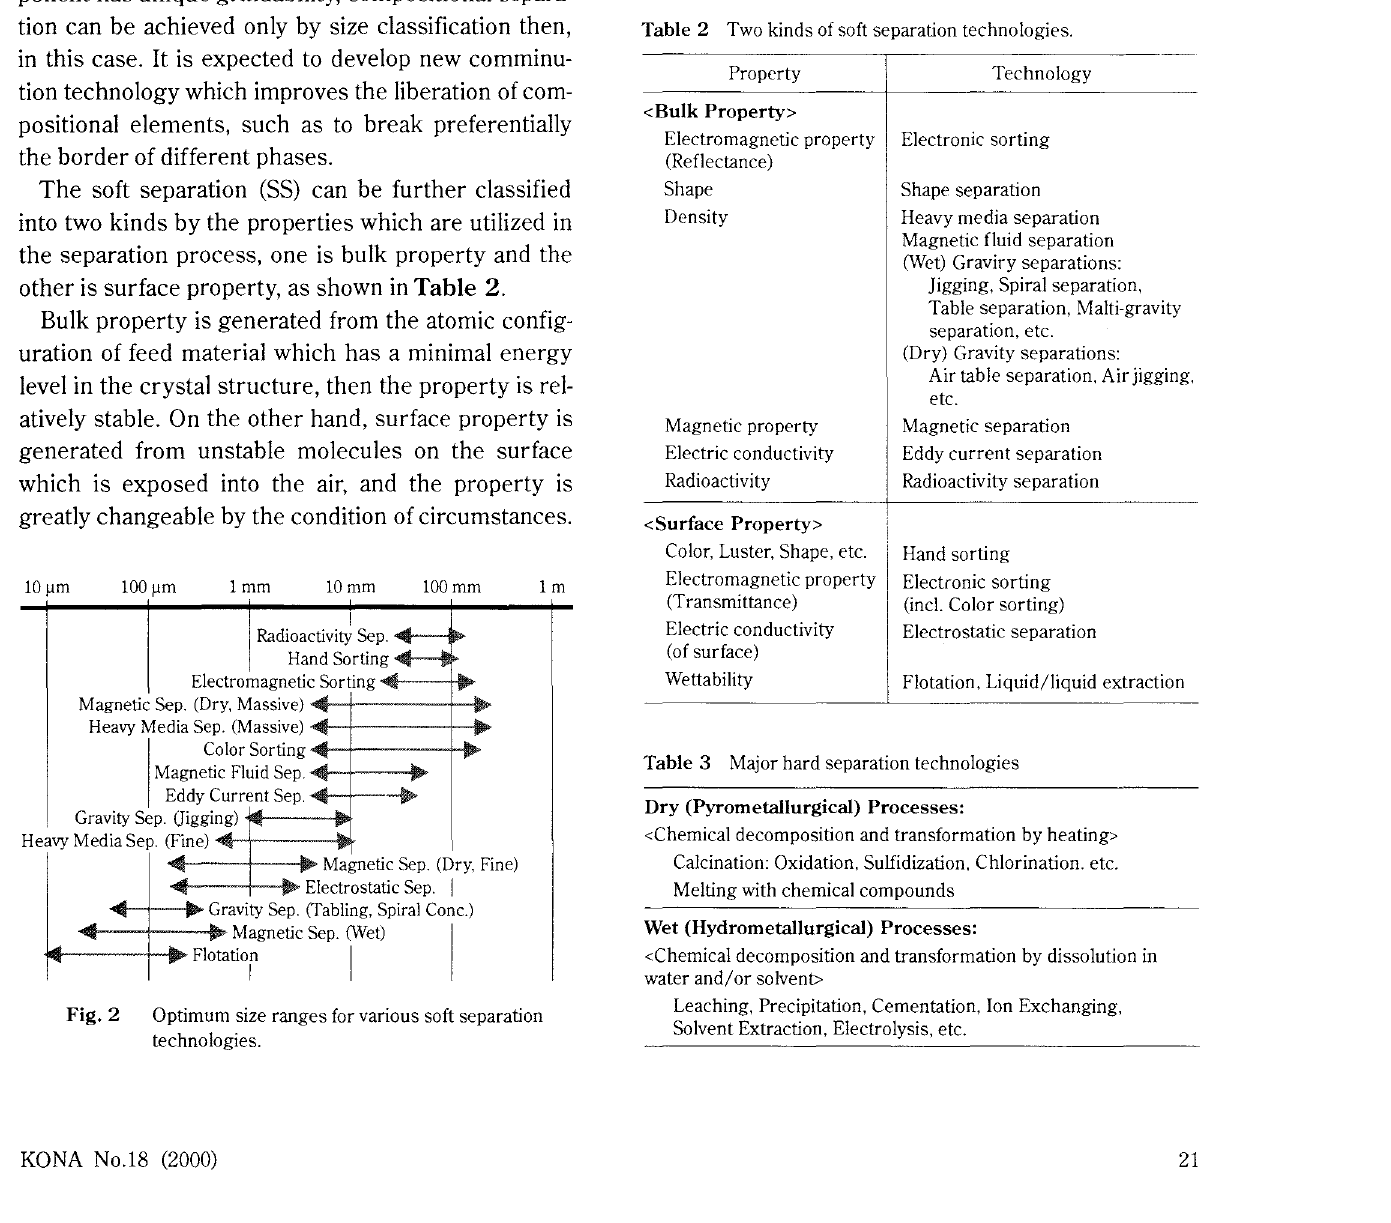
Table 2 Two kinds of soft separation technologies.